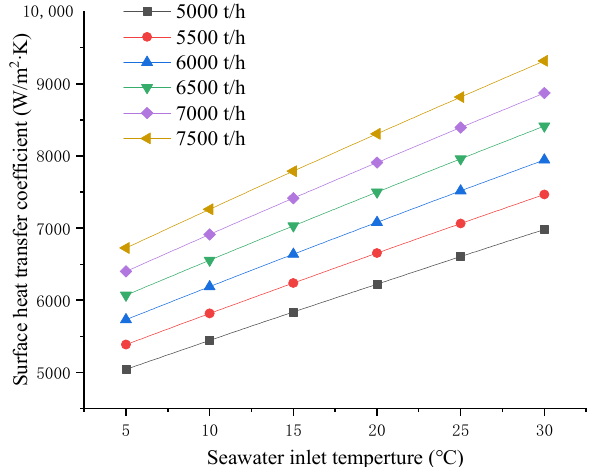
Figure 11. Surface heat transfer coefficient on the tube side at different seawater mass flow rates and temperatures in the NG heater.